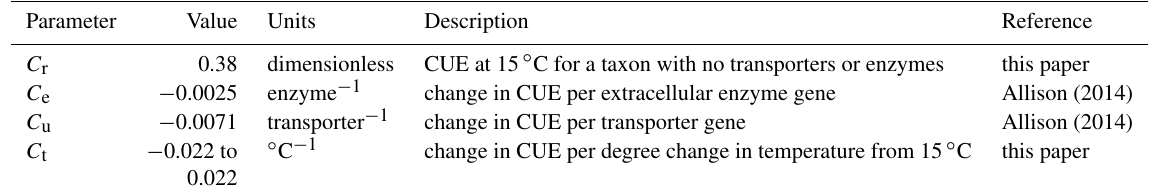
Table 1. CUE-related model parameters mentioned in this paper. The complete set of parameters can be found in the params.txt file in the